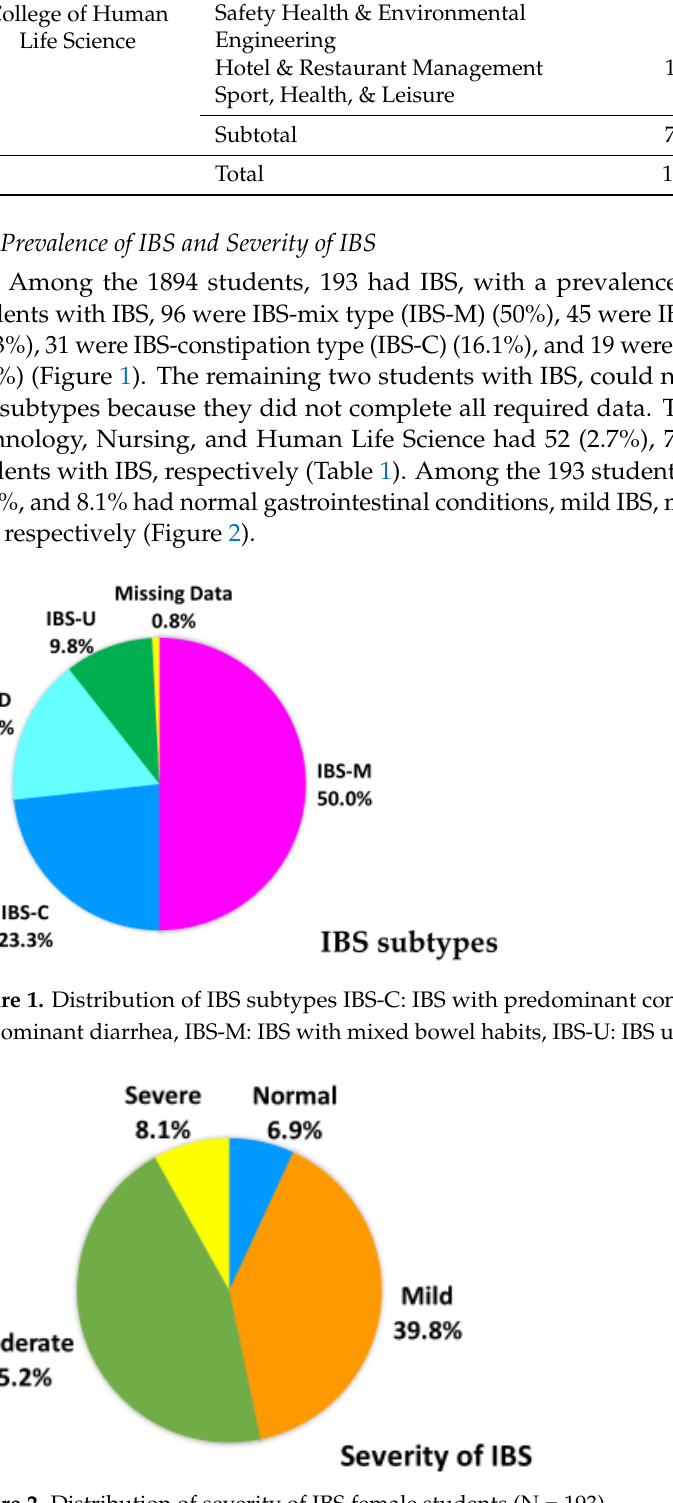
Figure 2. Distribution of severity of IBS female students (N = 193).